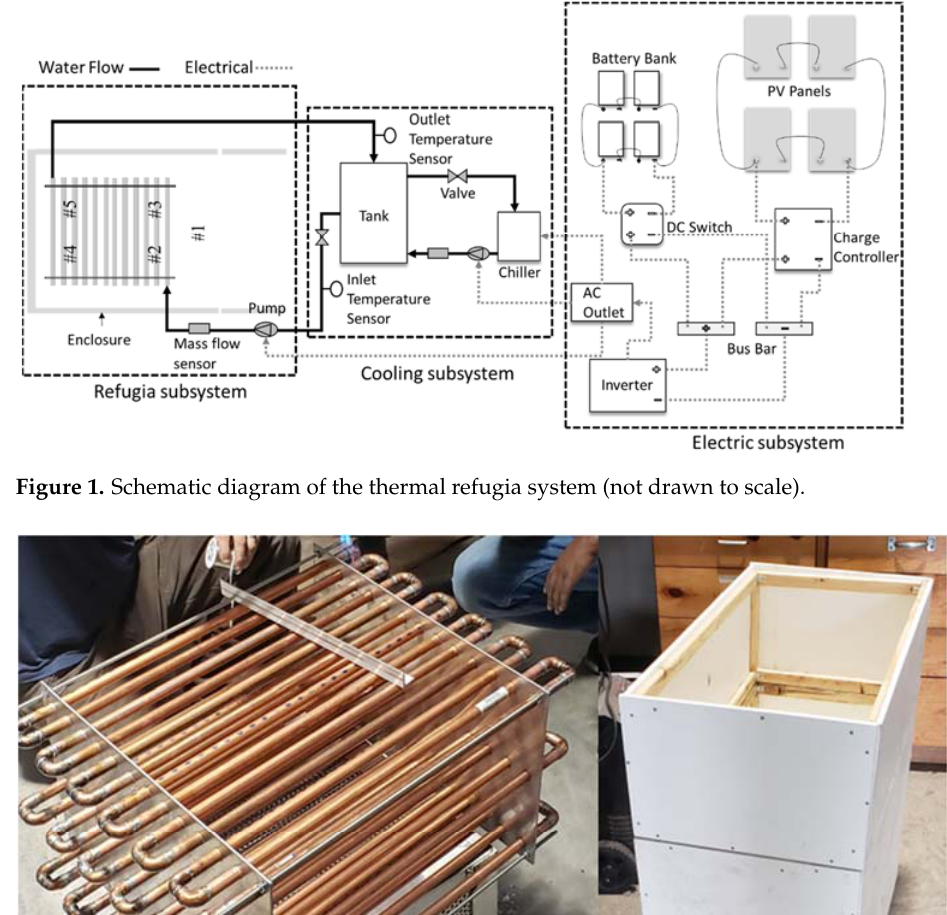
Figure 1. Schematic diagram of the thermal refugia system (not drawn to scale).